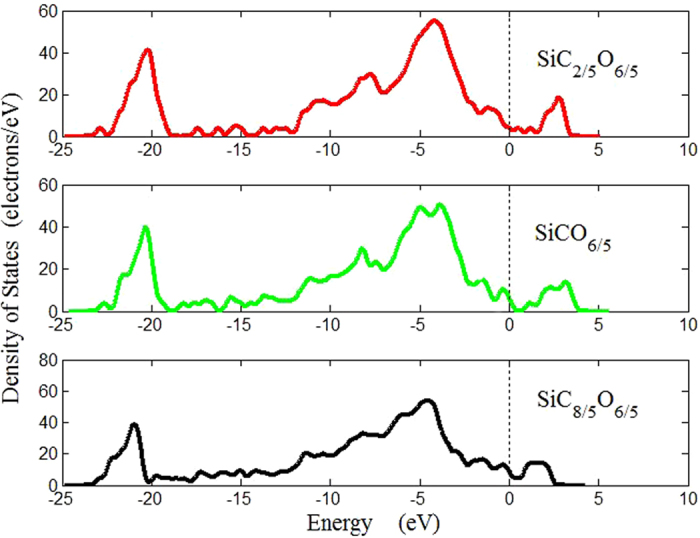
Density of states of the amorphous SiCxO6/5 structures.